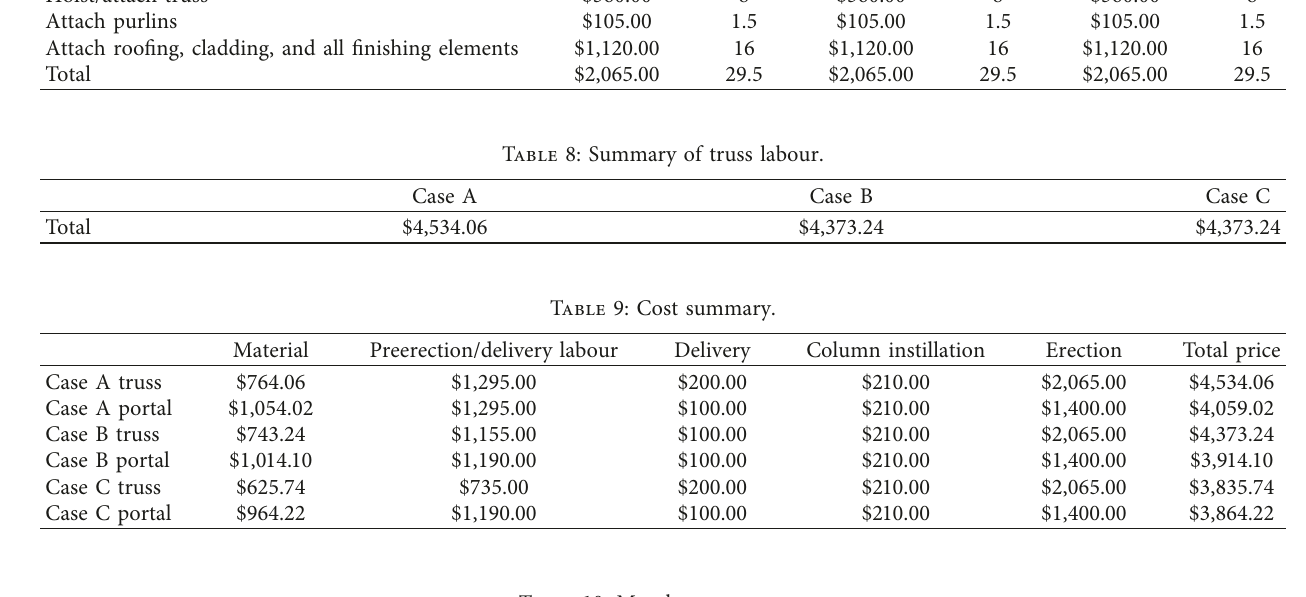
Table 10: Man hour summary.